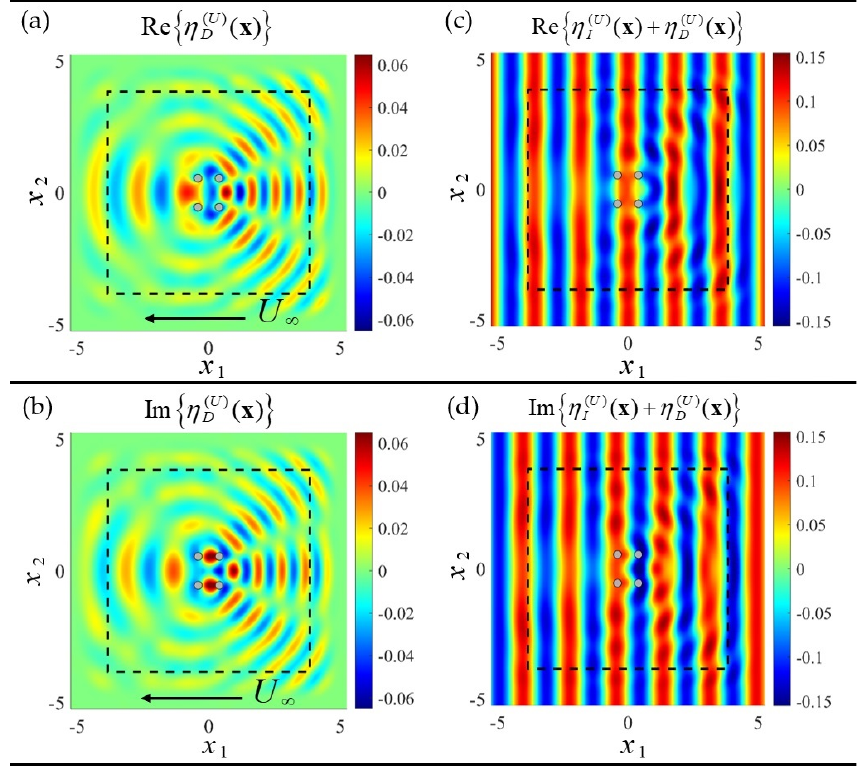
Figure 7. Incident waves of wavelength and height λ = 1.2m, H = 0.1m interacting with an arrangement of four cylindrical scatterers of diameter D = 0.3 m in water depth h = 1m, in the presence of a collinear following current U ∞ = ( − 0.25m/s,0,0 ) , indicated with an arrow. ( a , b ) Real and imaginary part of free surface elevation of the diffracted and ( c , d ) the total unsteady field, respectively. The dashed line indicates the absorbing layer region.